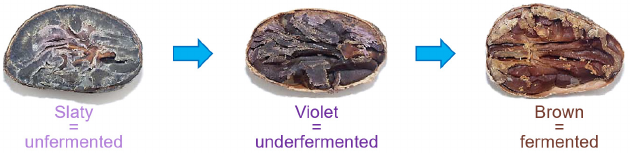
Fig. 3: Color change of Cocoa seeds during fermentation and drying. (im- ages of cocoa taken from r ohsius